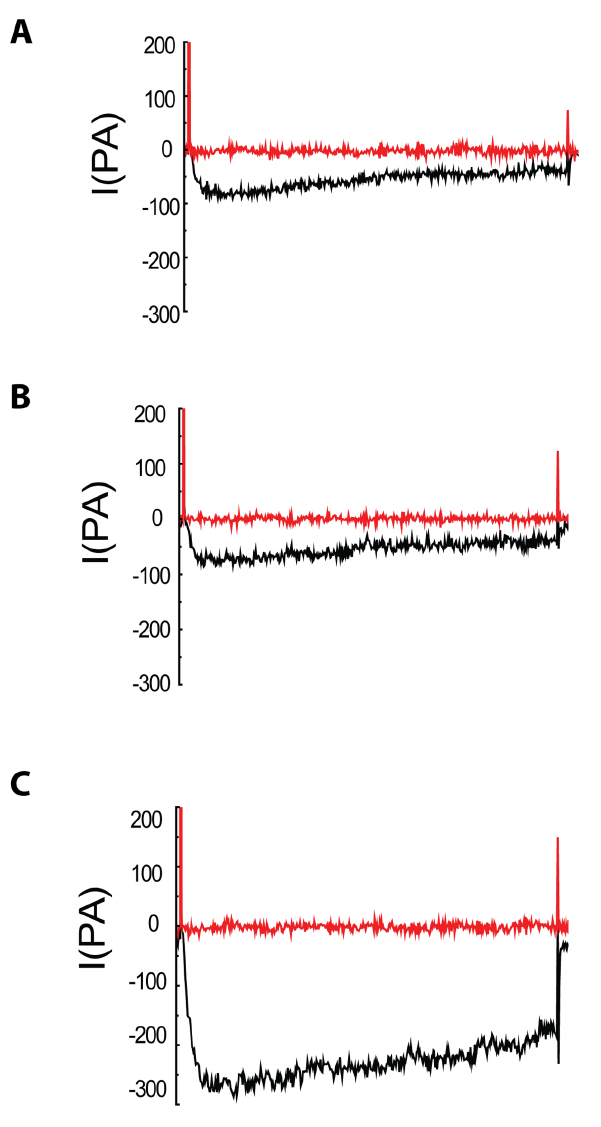
Figure 5. Analyses of current–voltage relationship for Ca + 2 channel currents in rabbit basilar artery smooth muscle cells after SAH. The graph A , B and C showed the inhibitory effect of nifedipine on the currents of VDCCs in control (C) group, sham (N) group and SAH group respectively. The results confirmed nifedipine could inhibit the currents of VDCCs in every group.